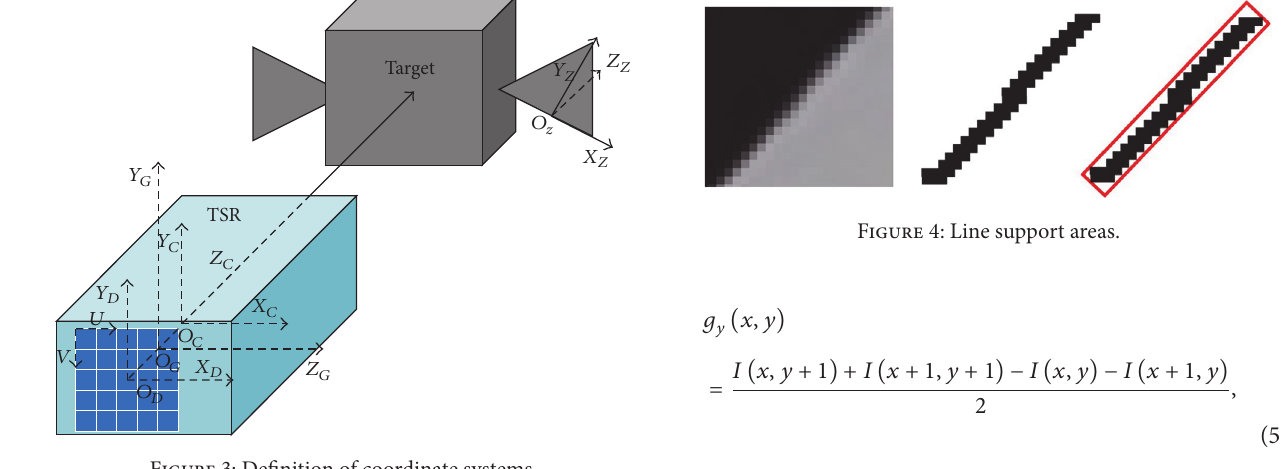
Figure 3: Definition of coordinate systems.